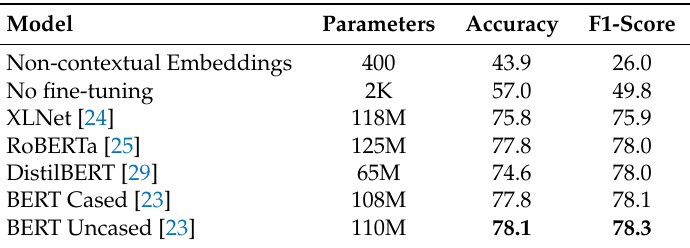
Table 3. Classifier prediction results for